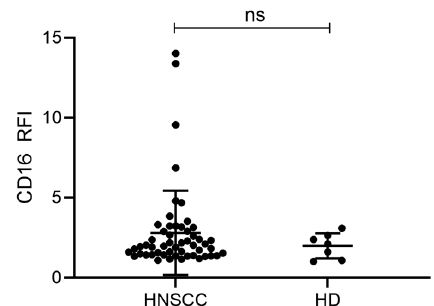
Figure 3. CD16 levels on plasma-derived exosomes from HNSCC patients and HDs. Total exosomes from HNSCC patients (n = 53) or HDs (n = 7) were stained for CD16 and surface levels as determined by on-bead flow cytometry are shown as RFI compared to an appropriate isotype control. Bars represent mean with SD. P values were determined by Mann–Whitney test, with ns = not significant.